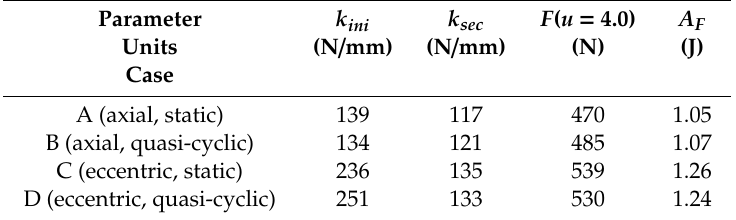
Table 10. Quantitative comparison of the results for the test samples with the mineral wool core. Parameter k ini k sec F ( u = 4.0) Units